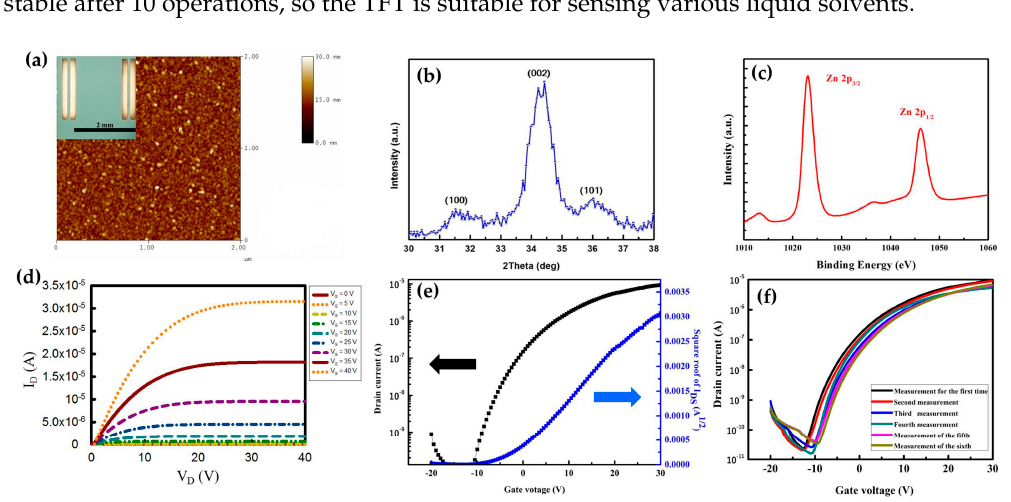
Figure 2 Figure 2. Physical analysis and electrical characterizations of ZnO-based TFTs in a dry environment: ( a ) Atomic force microscope (AFM) and the optical microscope (OM) image (inset) of the TFT; ( b ) X-ray diffraction (XDR) spectrum in the range of 30 ◦ –38 ◦ ; ( c ) The X-ray photoelectron (XPS) spectrum of ZnO film showing Zn 2p peaks; ( d – f ) The electrical characterizations of the TFT; ( d ) I DS -V DS curves, drain current as a function of drain voltage with the bottom gate voltage (V GS,bottom ) varying from 0 to 40 V with steps of 5 V; ( e ) I DS -V GS, drain current versus bottom gate voltage (V GS,bottom ) varying from − 20 to 30 V with steps of 500 mV, with the drain voltage being fixed at 5 V and the drain current being plotted on a logarithmic scale (left) and the square root of drain current plotted on a linear scale (right); ( f ) The endurance test for 10 iterations of I DS -V GS